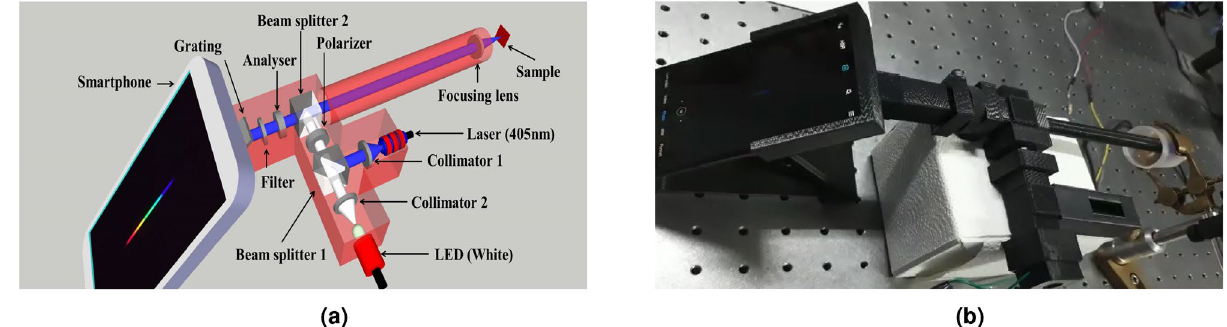
Figure 1. ( a ) Schematic (drawn using an open access software, SketchUp 2014, www. sketc hup. com ) and ( b ) working set-up of smartphone-based polarized fluorescence detection